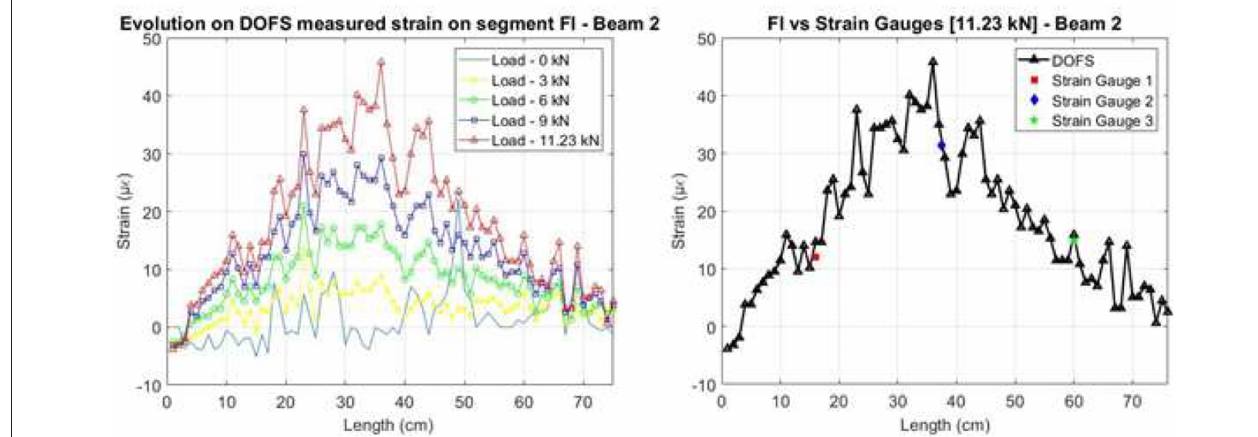
FIGURE 5 | Strains measured by the DOFS on the embedded segment for Beam 2.